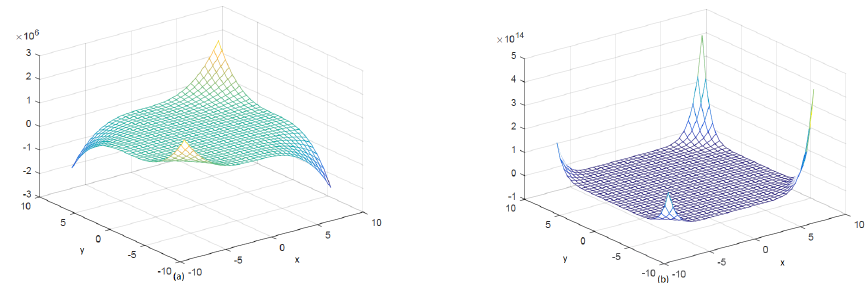
Figure 14: Plotting of (a) M-polynomial and (b) NM-polynomial of Perfragilin A. Corolary 2.13. Let G be the molecular graph of Perfragilin A.